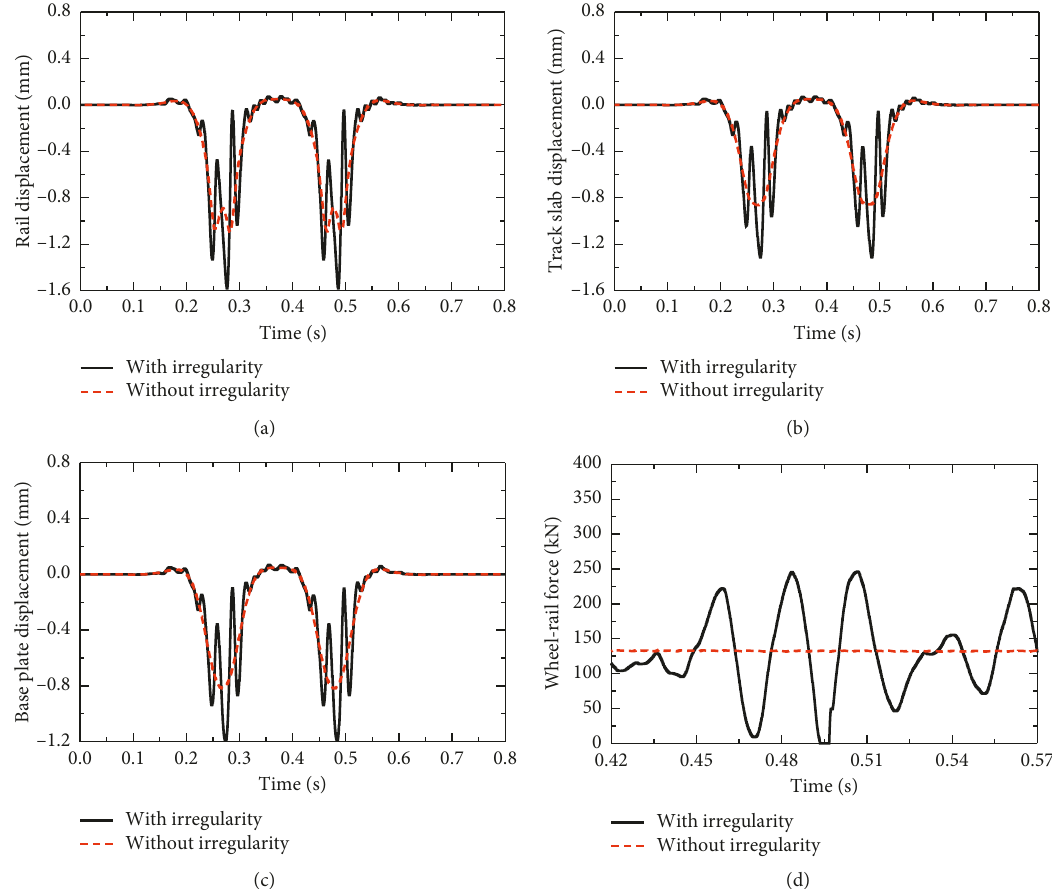
Figure 8: Responses of the track with the Beijing–Shanghai track irregularity: (a) rail displacement; (b) track slab displacement; (c) base plate displacement; (d) wheel-rail force at the 1 st